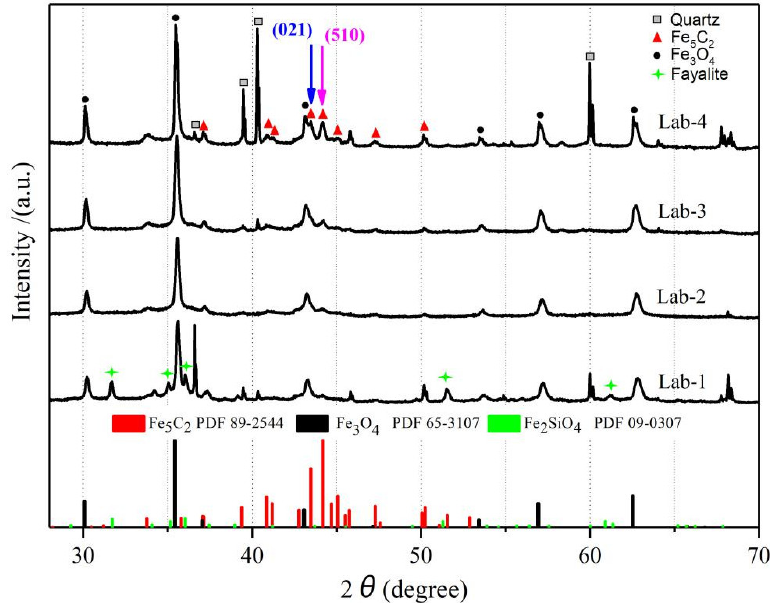
Figure 14. XRD pattern of the spent catalyst samples following FTS reaction (c.a. 280 h).